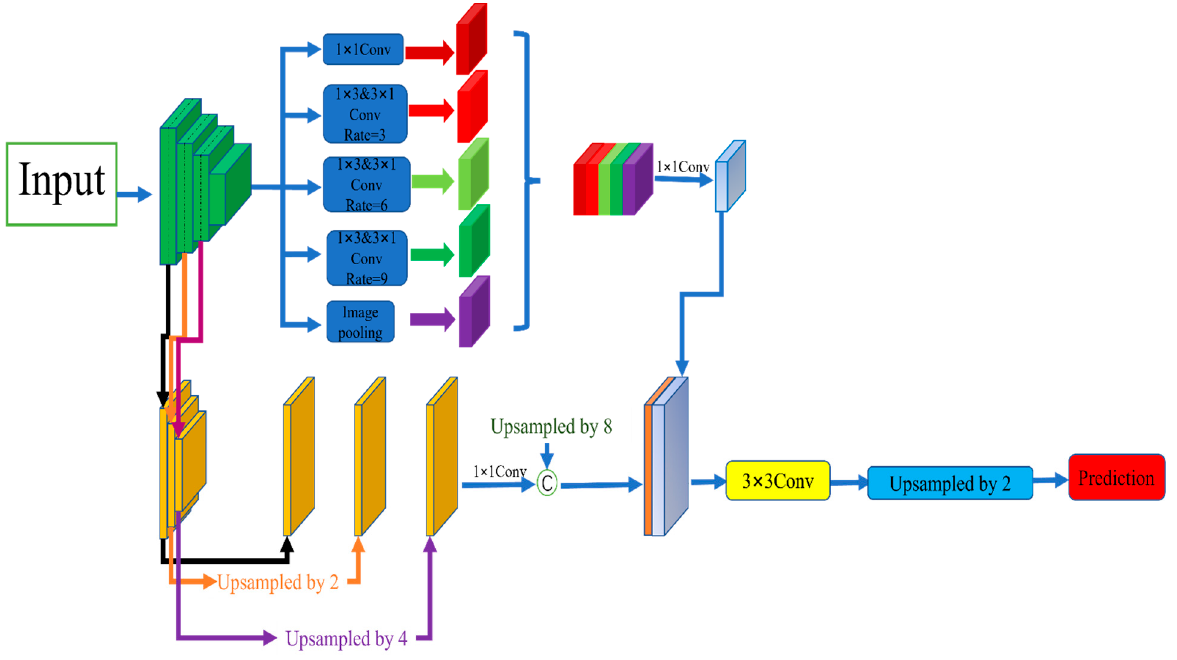
Figure 1. The overall structure of the proposed DeepLabV3+